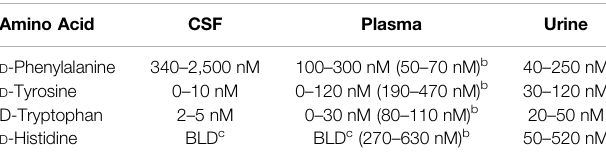
TABLE 3| Concentrations oftheD-Aromatic Amino Acidsinhumanbodily fl uids a